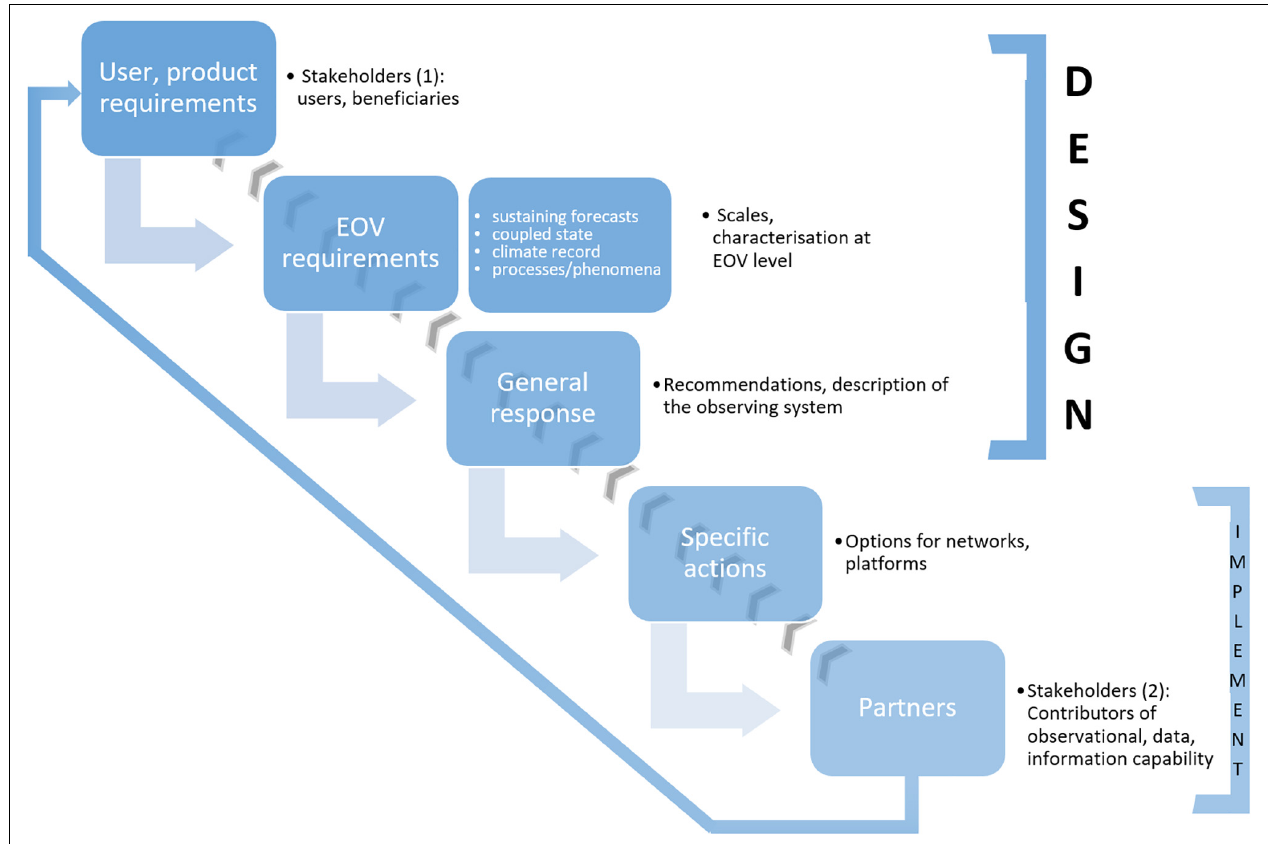
FIGURE 1 | Schematic of the process deployed by TPOS 2020 in the First Report (an adaptation of the Framework for Ocean Observing, Lindstrom et al., 2012). The design is user driven and some form of stakeholder “market” analysis is required to define needed products, including resolution, accuracy and so on. In some cases (e.g., research) the users may provide this specification in terms of variables. The second level is a set of requirements expressed in terms of characteristics (scales, etc.) of Essential Ocean/Climate Variables. At the next level the TPOS 2020 considered a general response in the form of recommendations; these may be thought of as observing system requirements. The specific response (level four) is expressed as a set of actions and recommendations at the level of networks and platforms. Finally, and most importantly, partners in the TPOS (a 2nd set of stakeholders) contribute the needed observational capability and capacity. Feedback occurs as part of the process, and directly between the final level (partners) and users/beneficiaries (the arrows from bottom right to top